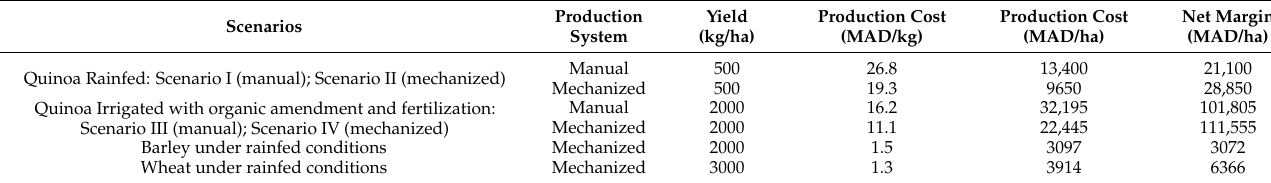
Table 4. Production cost and net margin of processed quinoa seeds compared to traditional cereals cultivated in the Rehamna region. 1 USD = 9